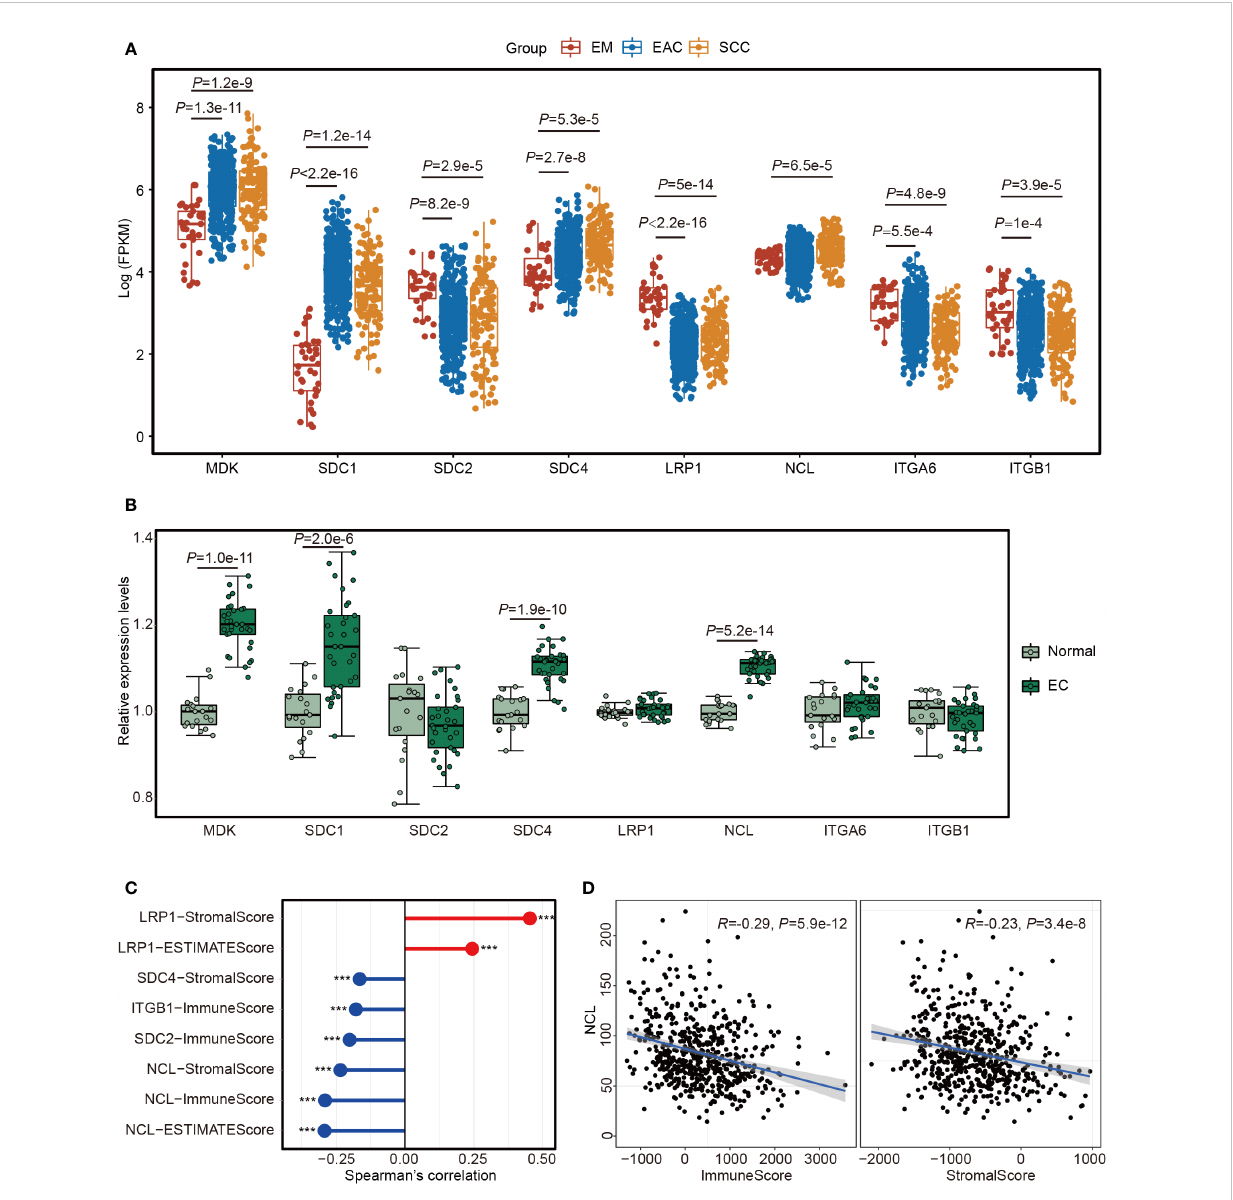
FIGURE 6 The expression of the 8 genes involved in MK signaling network. (A) Boxplot showing the expression levels of the 8 genes in TCGA samples from endometrium (EM, n = 35), serous cystadenocarcinoma (SCC, n = 133) or endometrioid adenocarcinoma (EAC, n = 401). (B) Boxplot showing the expression levels of the 8 genes in 32 endometrial carcinoma (EC) tissues and 19 normal endometrial tissues. (C) Lollipop chart showing the signi fi cant associations between the 8 genes and the scores estimated by “ estimate ” package with the TCGA data. *** P <0.001. (D) Scatter plots showing the Spearman ’ s correction between NCL and ImmuneScore or